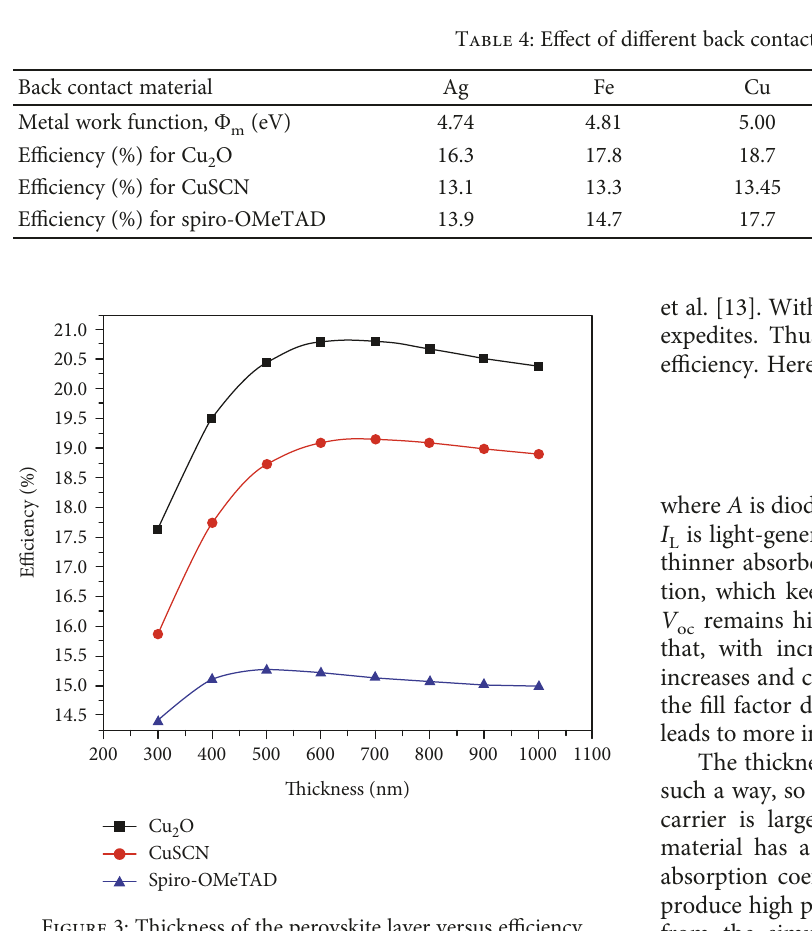
Figure 3: Thickness of the perovskite layer versus e ffi